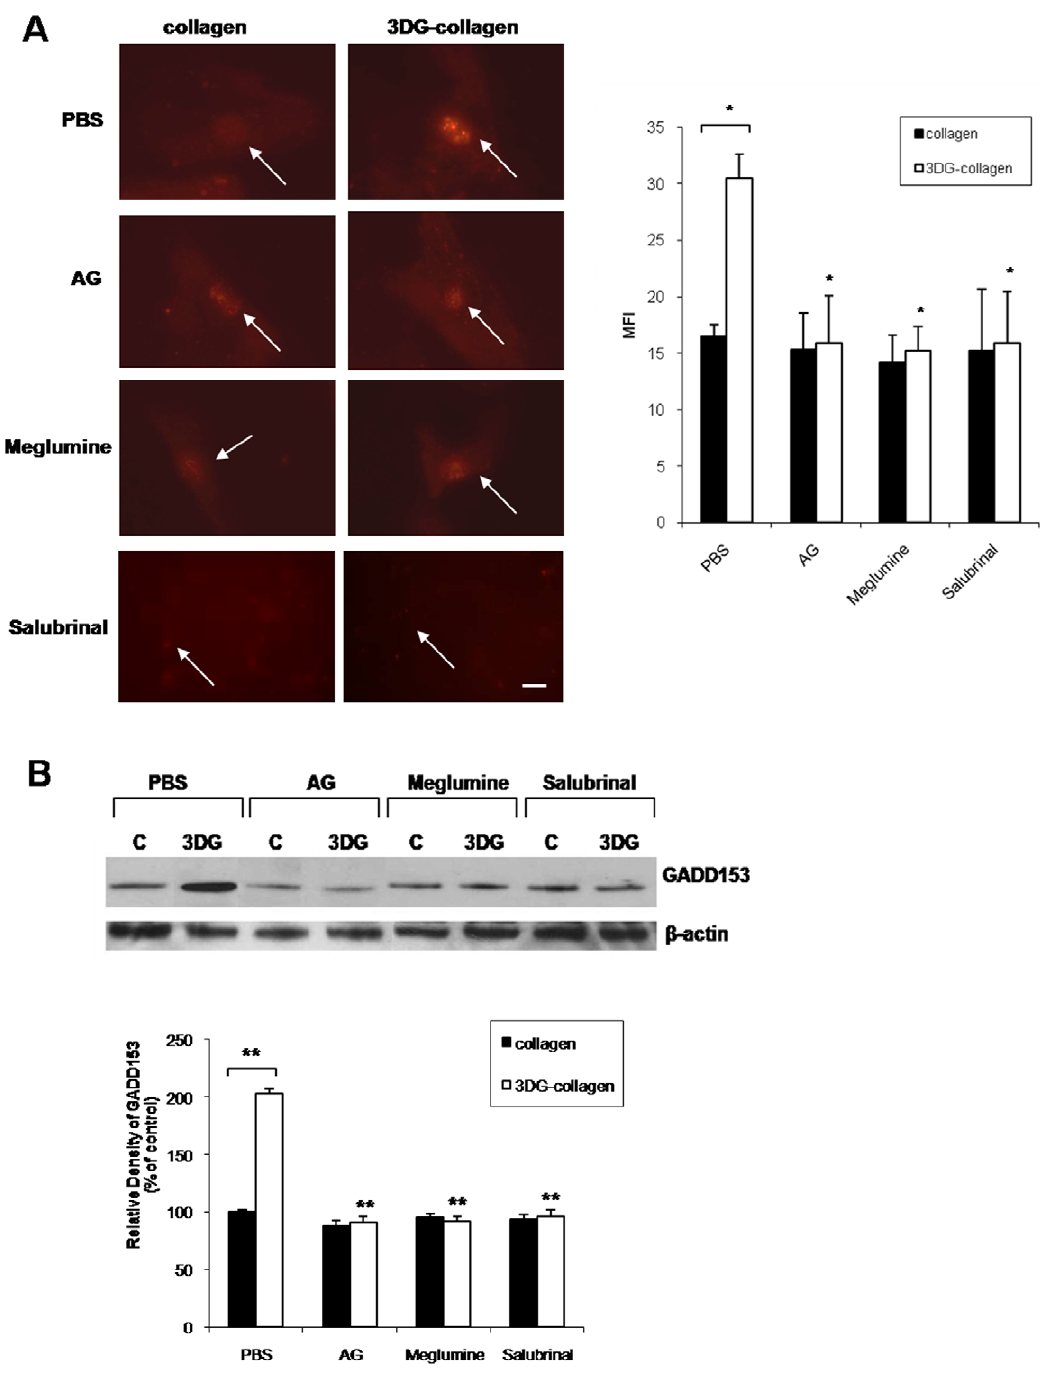
Figure 2. Effect of ER stress inhibitor salubrinal on 3DG-collagen-induced GADD153 expression. A , Fibroblasts were cultured in chamber slides coated with native collagen or 1 mM 3DG-collagen with or without 5 mM AG or 40 mM meglumine for 24 h. Also, fibroblasts were pretreated for 1 h with or without 40 m M salubrinal and then cultured on native collagen or 3DG-collagen for 24 h. Fibroblasts were stained and analyzed for expression of GADD153 in the nucleus by immunofluorescence analysis using Cy3-conjugated secondary antibody. Mean fluorescence intensity (MFI) of GADD153 in the nucleus was measured using ImageJ from ten representative fibroblasts. Images were taken at 40 6 magnification on an epi- fluorescent microscope. Arrows indicate nuclei containing GADD153. The bars represent the MFI values from each experimental condition. Scale bar represents 10 m m. B , Fibroblasts were treated as in A followed by Western blot for GADD153 expression. b -actin was used as a loading control. The bars represent the densitometric value for each experimental condition. All comparisons are made against 3DG-collagen treated with PBS unless otherwise indicated. Data are mean 6 SD (n=3), **P , 0.0005, *P , 0.007.